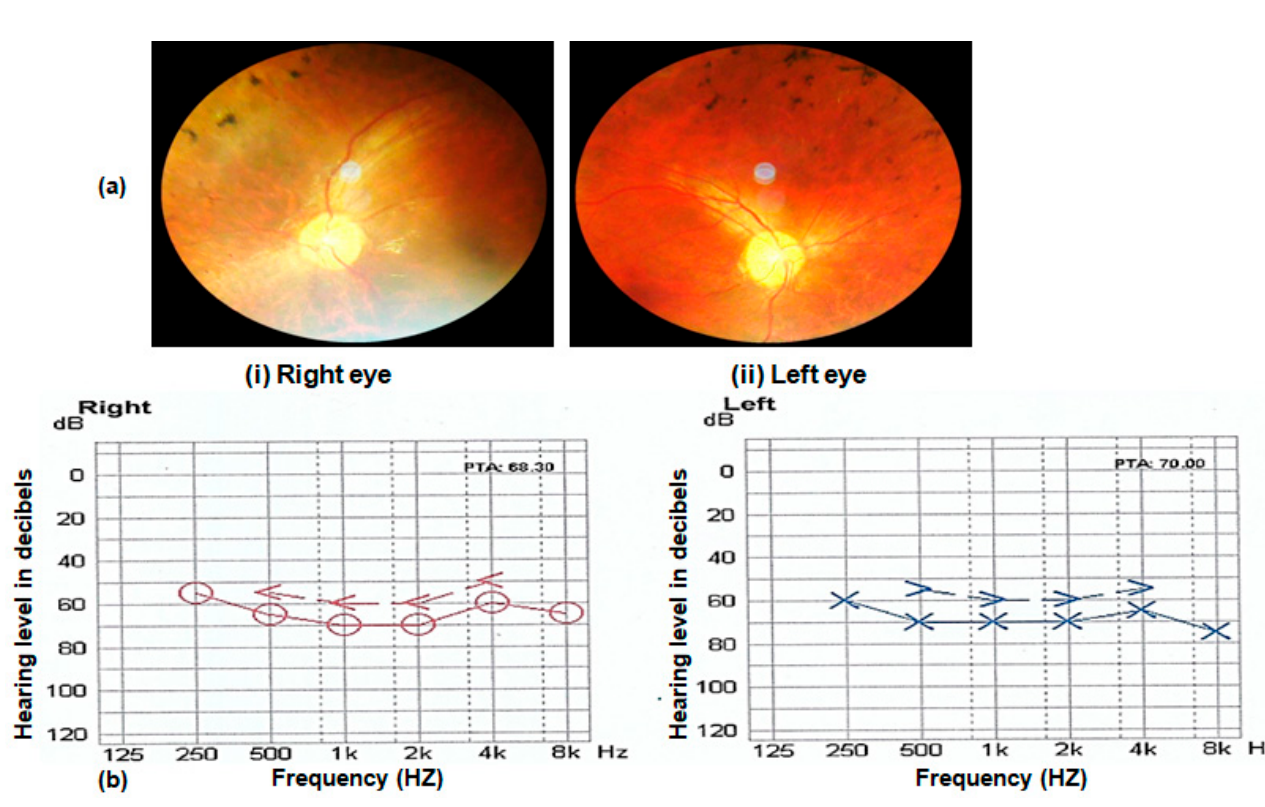
Figure 3. ( a ) Fundus photograph of left and right eye of an affected individual (V.II of RP105) showing pale optic disc, bony spicules and thin blood vessels characteristic of RP phenotype. ( b ) Audiometry report of an affected individual (V.II of RP105) performed at 14 years. The x-axis on graphs shows the frequency in hertz, and the y-axis shows hearing level in decibels (dB). Note the hearing loss in the range of 50–80 dB in both ears of the Usher patient. To identify the underlying mutations of these families, NGS capture panel sequencing was per- formed on the proband of each family to screen for mutations in known inherited retinal diseases related genes. A total of 8 diverse types of pathogenic mutations from 7 different genes were iden- tified, including 2 missense, 3 nonsense, 2 frameshift indel and 1 large deletion (Table 2, Figure 4 and Supplementary Figure S2). Table 2. List of previously reported and novel pathogenic variants identified in nine unrelated inherited retinal dystro- phies families segregating with disease phenotype in recessive form. Family ID